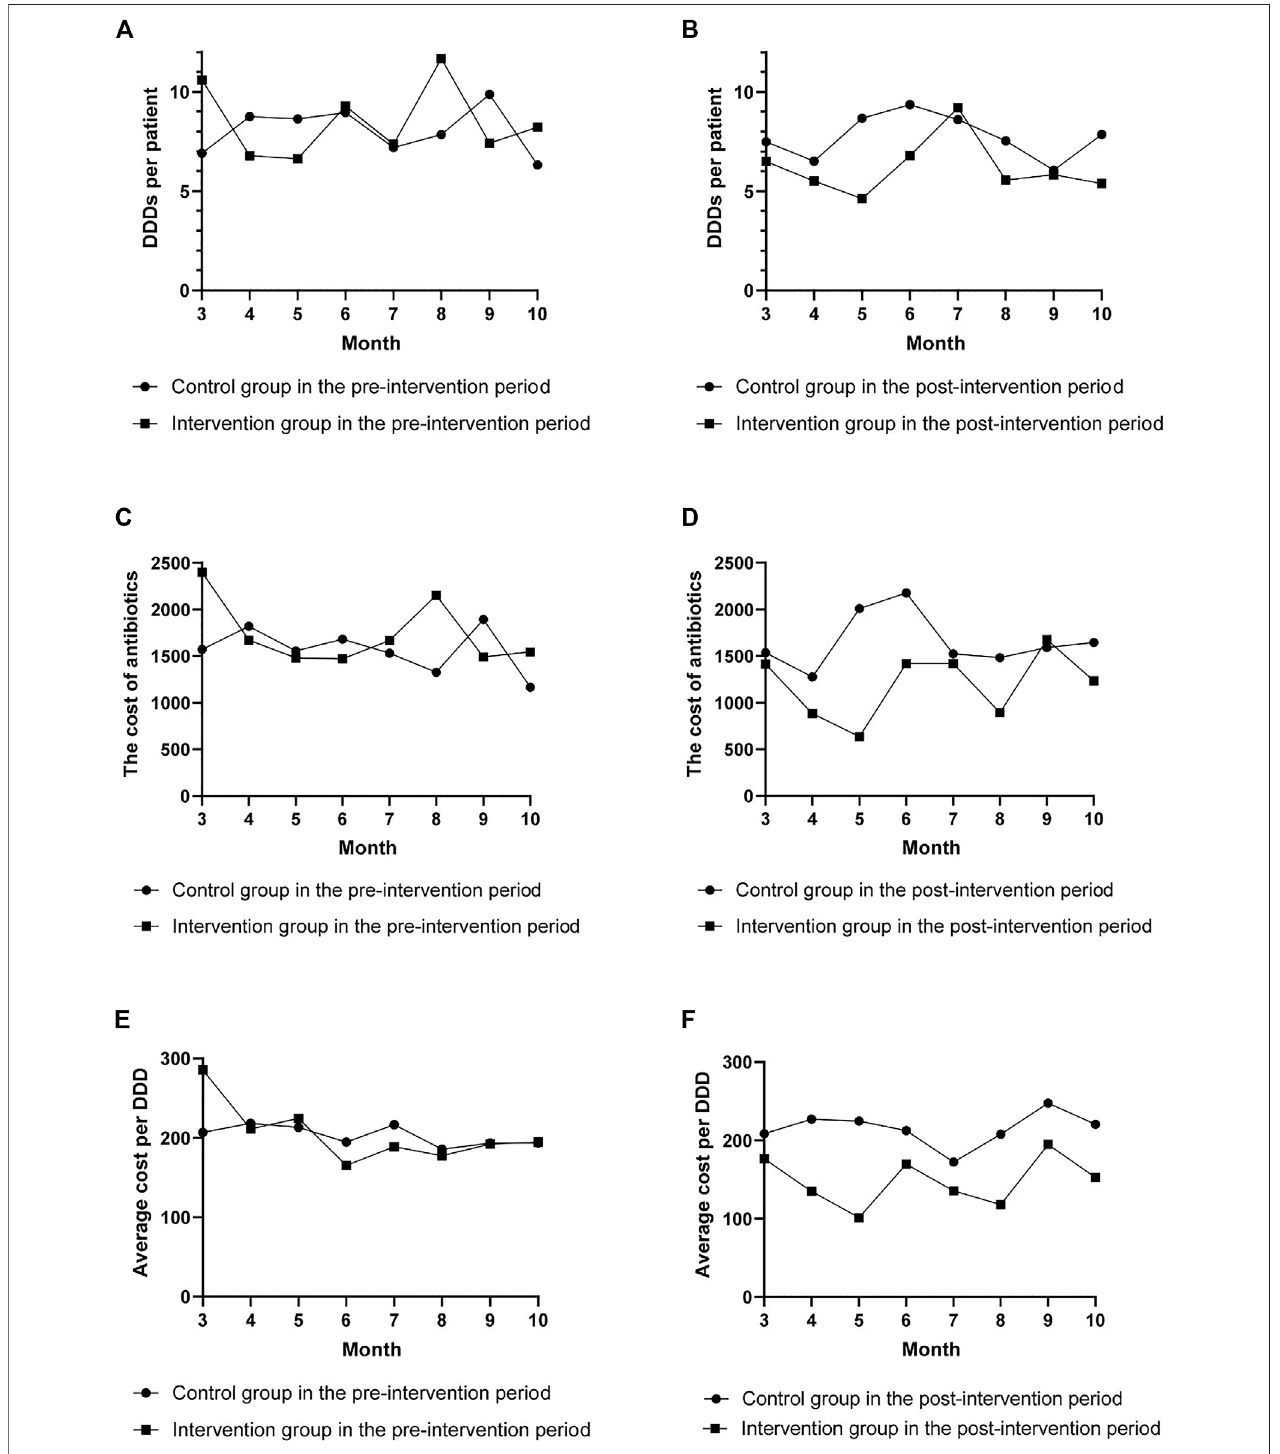
FIGURE 1 | The change in de fi ned daily doses (DDDs) per patient, cost of antibiotics, and average cost per DDD per month. The change in DDDs per patient (A) , cost of antibiotics (C) , and average cost per DDD (E) per month in the pre-intervention period. The change in DDDs per patient (B) , cost of antibiotics (D) , and average cost per DDD (F) per month in the post-intervention